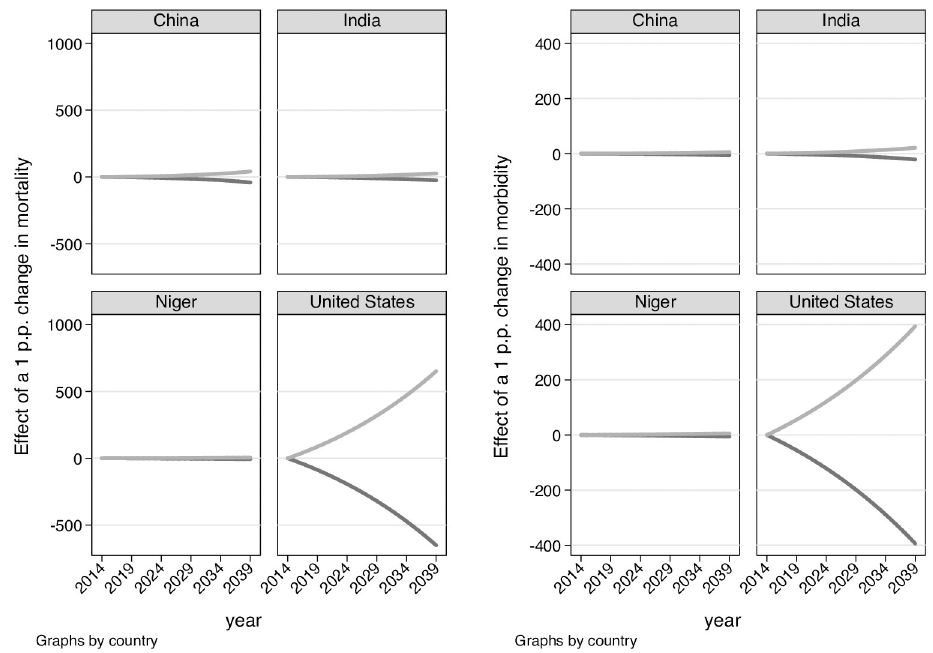
Fig 4. Differential GDP per capita under the action scenario compared to the status quo between 2015 and 2039. By year and country. Note: left panel: mortality; right panel: DALY. Positive action scenario in gray and negative action scenario in